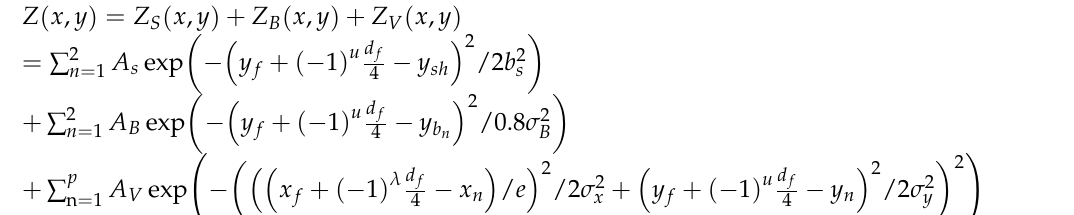
Figure 4. Flowchart for creating an adaptive grid risk-field. Substituting Equations (9) and (10) into Equation (6), the risk value of a grid after division is obtained as